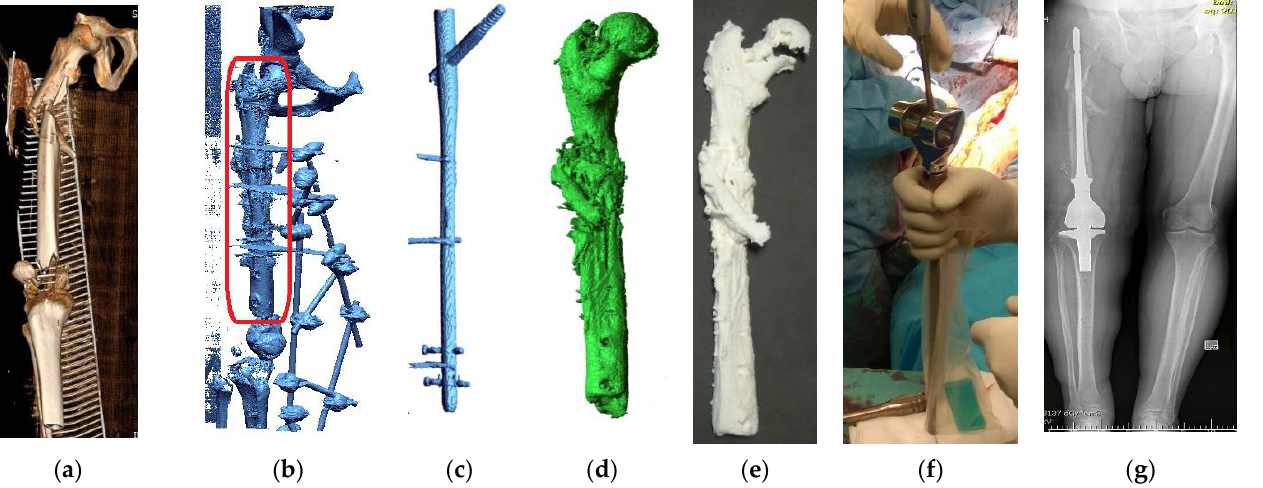
Figure 24. Process of planning the procedure as exemplified by Patient No. 2: ( a ) Diagnostics following an accident; ( b ) Reconstructing volumetric data, together with the marked area to be printed; ( c ) The digital reconstruction of the traction pin; ( d ) The digital reconstruction of the femoral bone; ( e ) The printed model of the femoral bone; ( f ) Prosthesis of the knee joint; and ( g ) Diagnostics following the performed procedure.